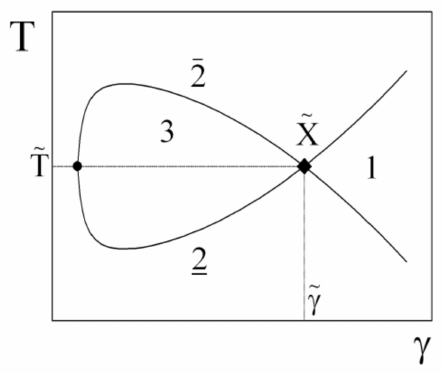
Figure 2. Scheme of a fish phase diagram of a microemulsion with nonionic surfactants: Temperature versus surfactant content. The di ff erent coexisting phases are indicated by the numbers. The fish tail point is indicated by (cid:101) X = ( (cid:101) γ , (cid:101) T ) .